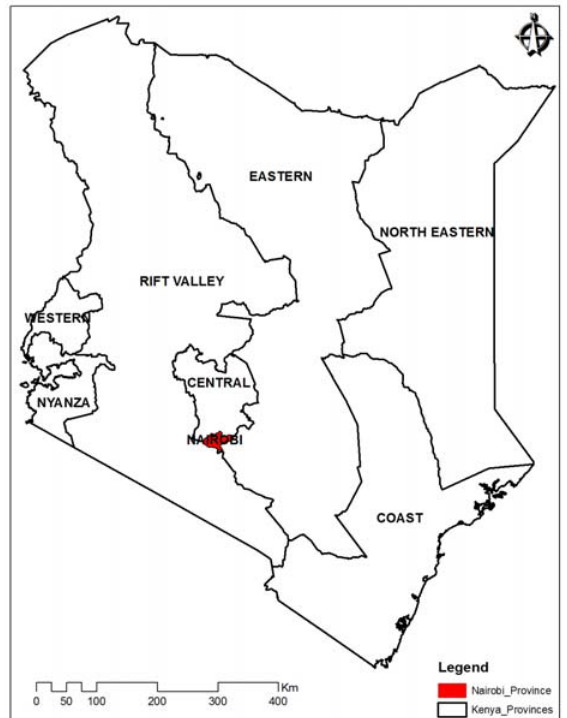
Map by Dennis Mwaniki. Figure 1b. Map of Nairobi Showing Study